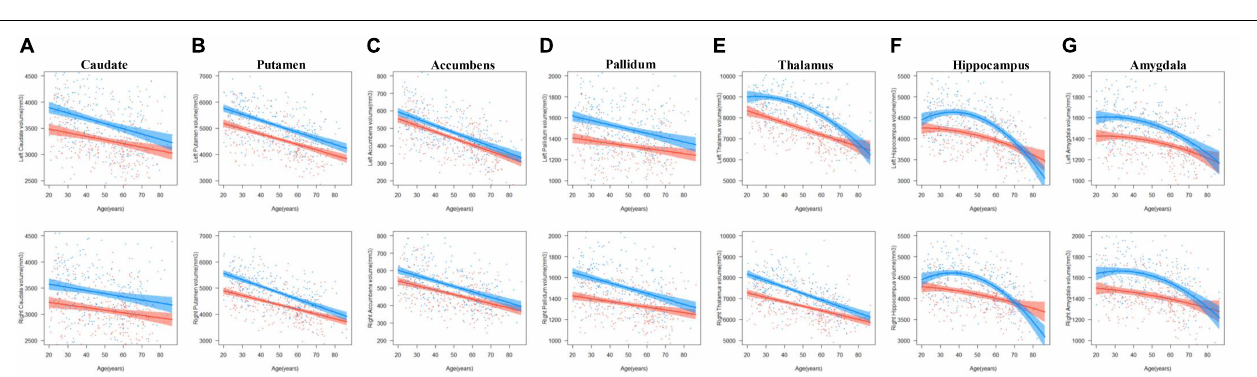
FIGURE 3 | The age trajectories of subcortical asymmetries, including the (A) caudate, (B) accumbens, (C) pallidum, and (D) hippocampus.